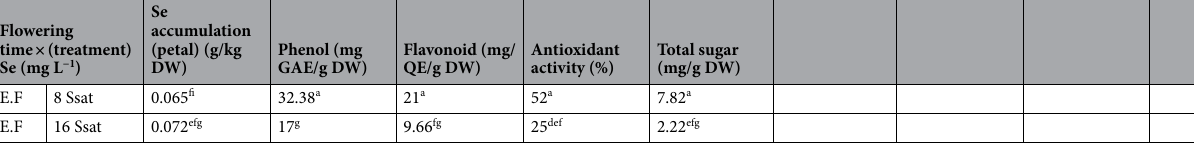
Table 1. The effect of selenium sources and flowering stages on some morphological characteristics of Echium amoenum. † Means within each column followed by the same letter are not different according to the